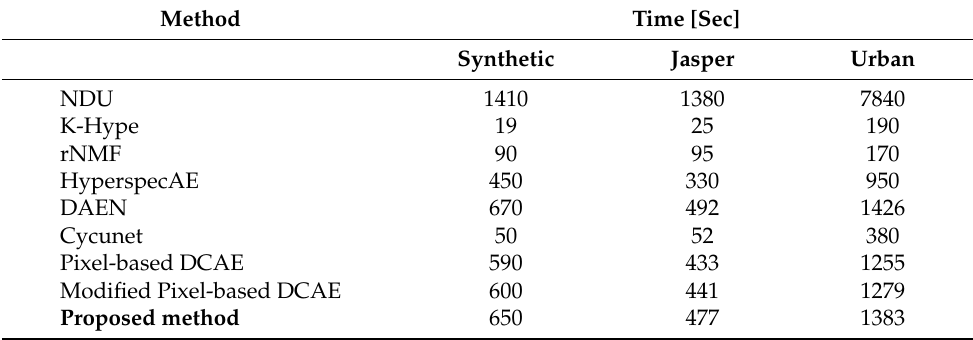
Table 7. The average computation time for each